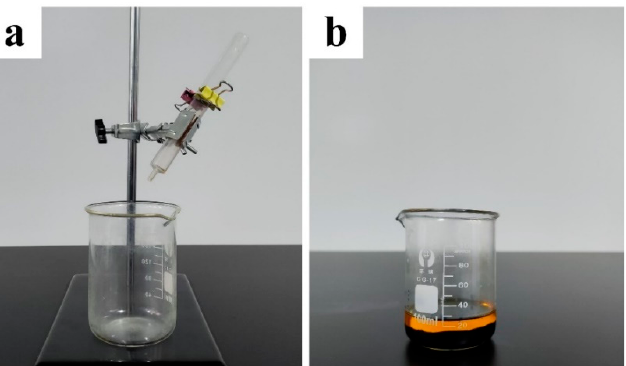
Figure 2. ( a ) Experimental setup for the oil–water separation test; ( b ) the oil–water mixture prepared in this work.